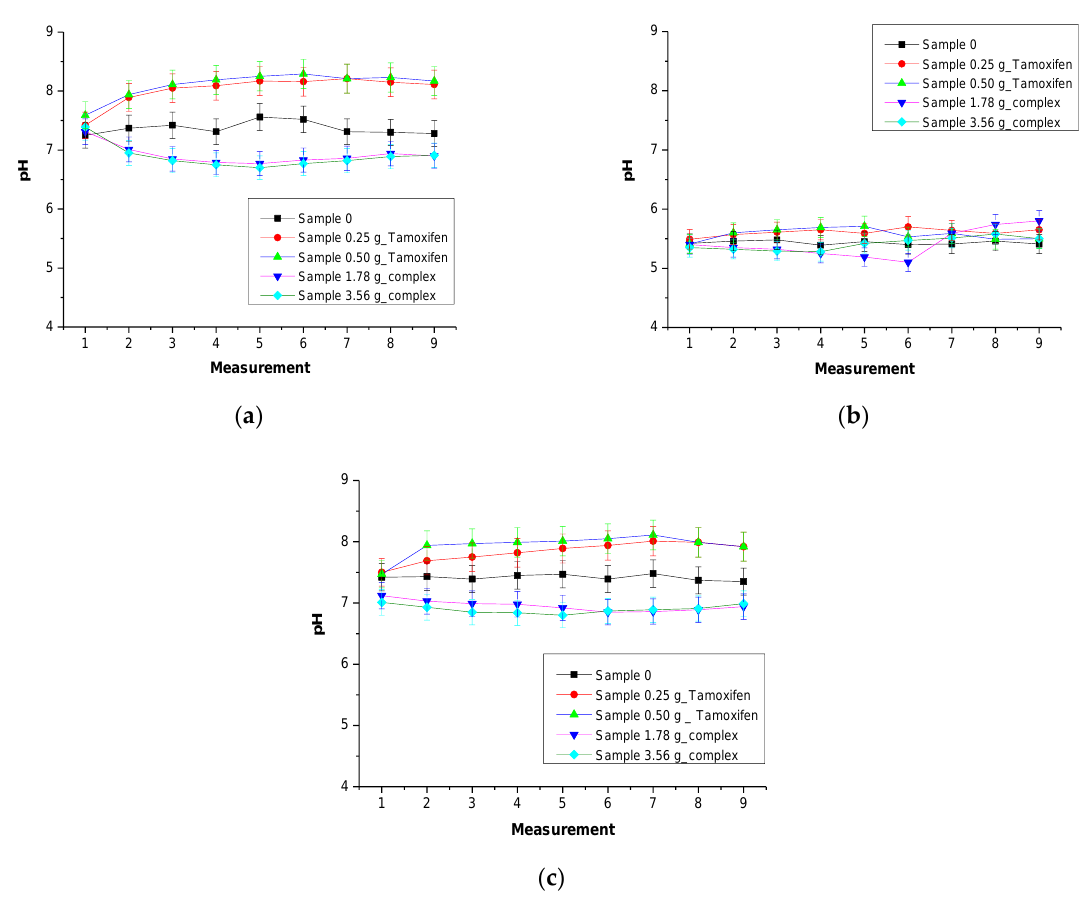
Figure 8. Results of incubation studies in distilled water ( a ), Ringer liquid ( b ) and SBF solution ( c ) (n — number of repetitions, n = 3).